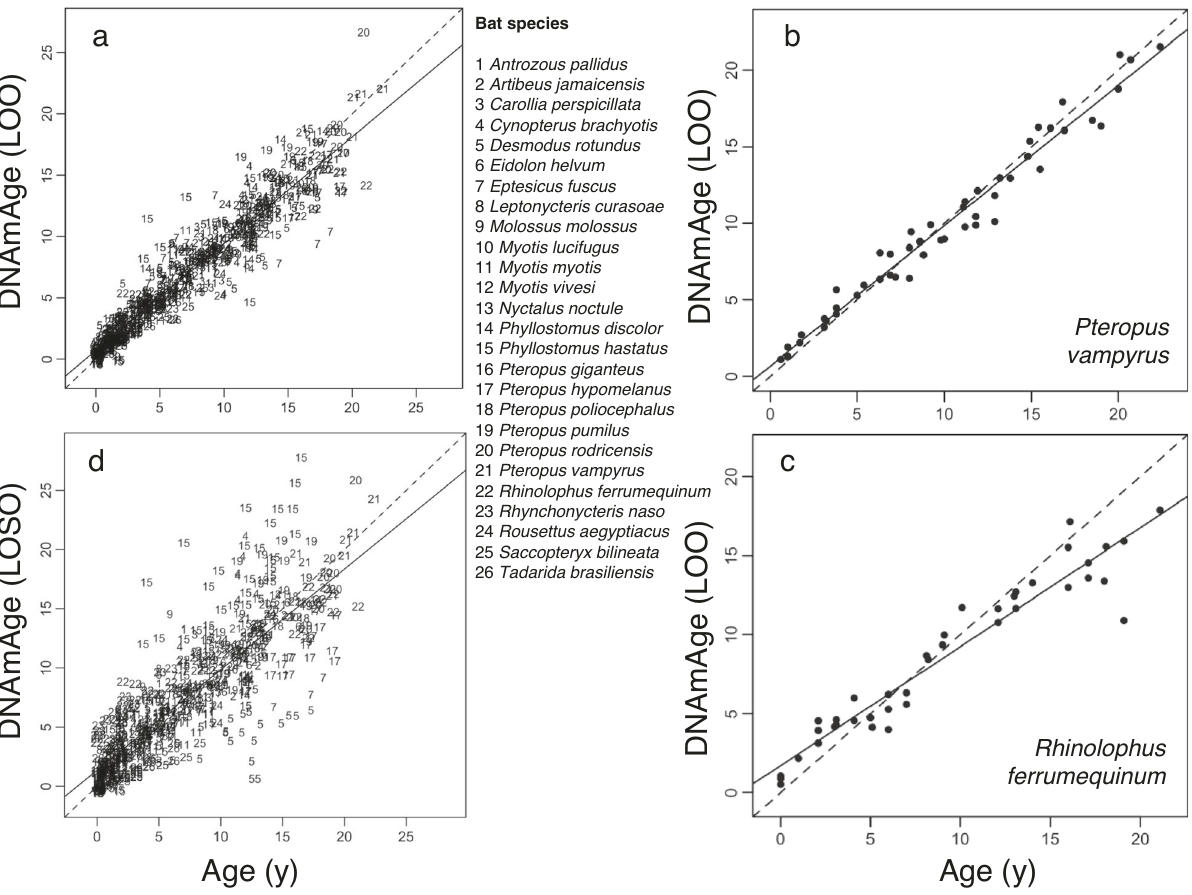
Fig. 1 Epigenetic clocks accurately predict the chronological age of bats. a Leave-one-out (LOO) cross-validation based on penalized regression gave a correlation of 0.95 with a median absolute error (MAE) of 0.74 years between observed and predicted (DNAmAge) age (after square-root transform) for 26 bat species. To ensure an unbiased cross-validation analysis, we allowed the number of CpGs to change with the respective training data. b LOO cross- validation based on penalized regression of 51 Pteropus vampyrus samples gave a correlation of 0.99 with MAE of 0.72 years between observed and predicted age. c LOO cross-validation based on penalized regression of 40 Rhinolophus ferrumequinum samples gave a correlation of 0.96 with MAE of 1.11 years between observed and predicted age. d Cross-validation analysis in which the DNAm data for one species was left out (LOSO) and ages are predicted for that species using a clock estimated with the remaining data. The resulting correlation between observed and predicted age is 0.84 (MAE = 1.41 years). Additional epigenetic clocks for individual species and genera are in Supplementary Figs. 1 and